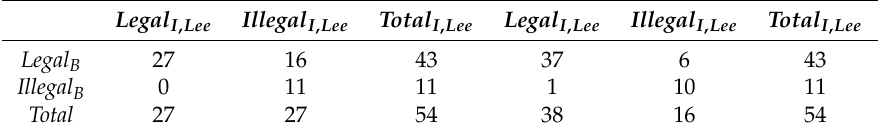
Table A4. Three multi-class confusion matrices for the three-levels classification on step sequences. On the left, the values for the Lee’s approach; on the right, the values for the proposed approaches. Legal B , Doubt B , and Illegal B refer, respectively, to “legal”, “doubt”, and “illegal” steps as classified